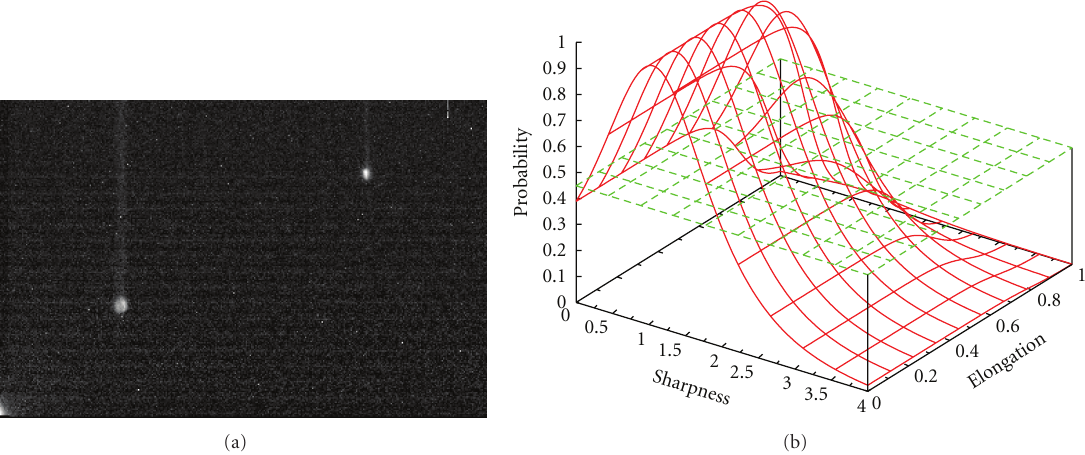
Figure 6: (a) A typical first image during the acquire phase. The image of the star through the beam splitter is the brighter spot to the left the fainter image to the right is the image from the mirror around the fiber entrance. The read-out stripes result from the shutter-less design. (b) The probability function used for identifying stars from their measured image elongation ( y , to the back) and sharpness ( x , to the right). The green, constant level at a probability of 0.446 is the threshold above which stars are identified. The two-dimensional function in red was derived by a manual training of the acquire system on 100 di ff erent